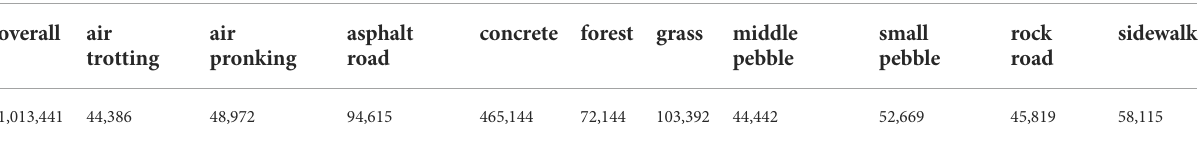
TABLE 3 Number of data of each terrain in the contact data sets. Terrain